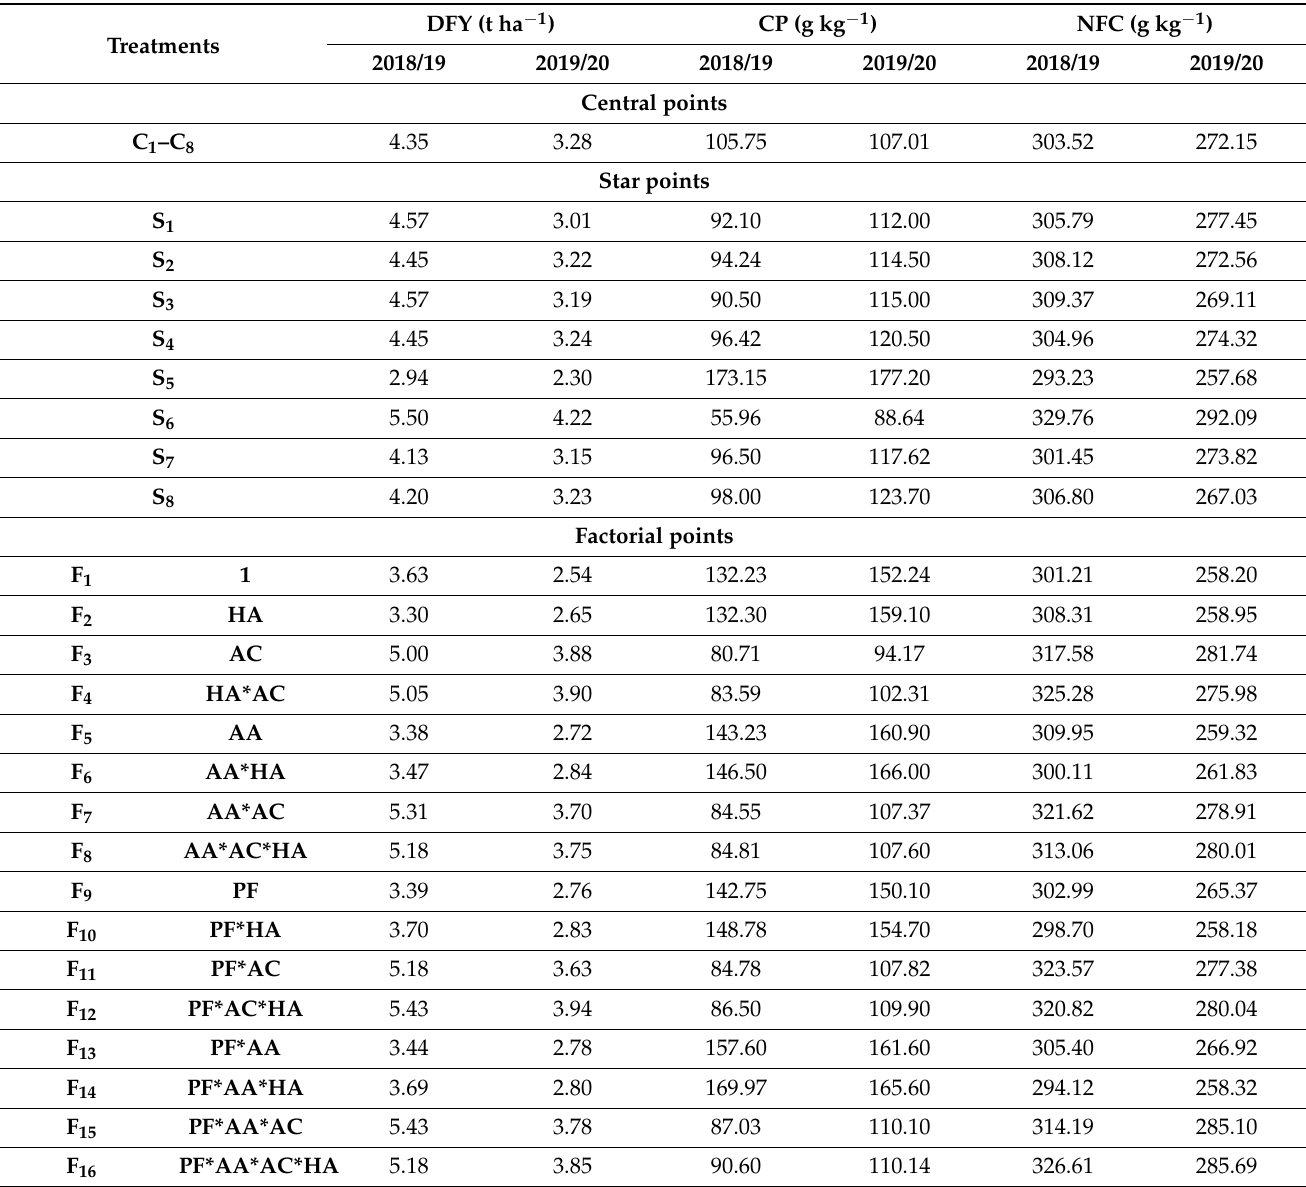
Table 5. Values of dry forage yield (DFY), crude protein (CP) and Non-fiber carbohydrates (NFC), as affected by the levels of PF, AA, AC and HA and their interactions in 2018/19 and